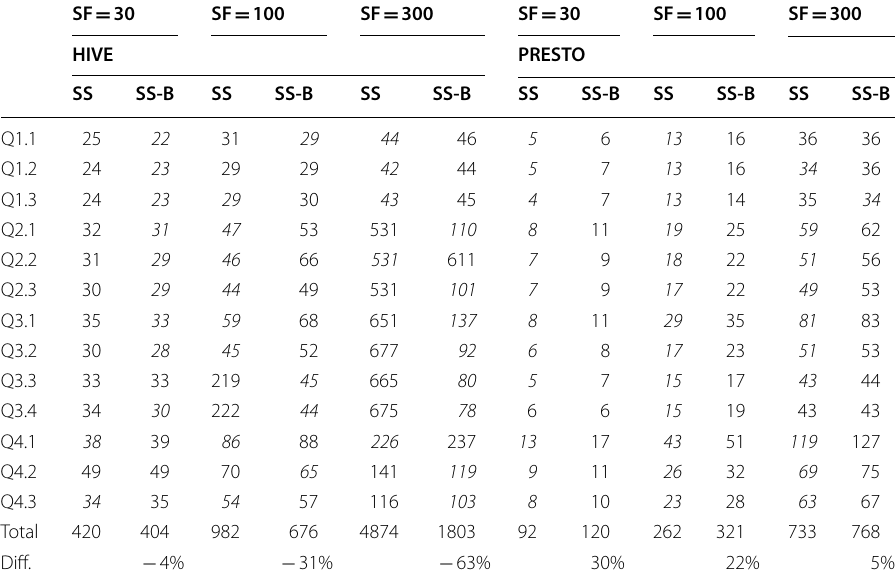
Italic values indicate the fastest processing time by query, workload, tool and data model